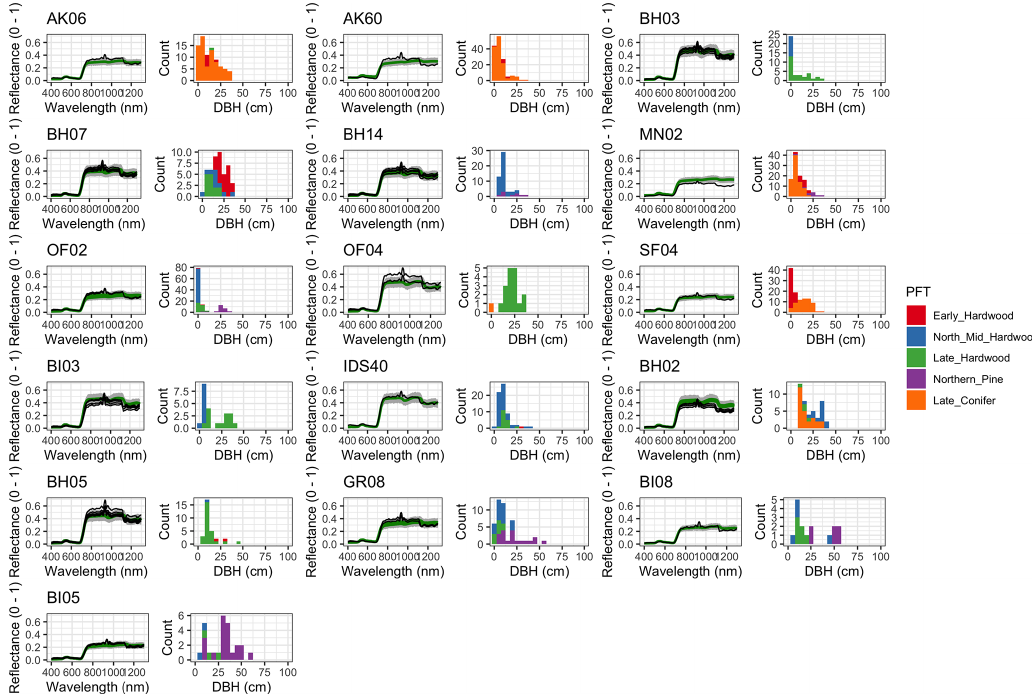
Figure A9. As above but for the third quartile of sites by DBH.